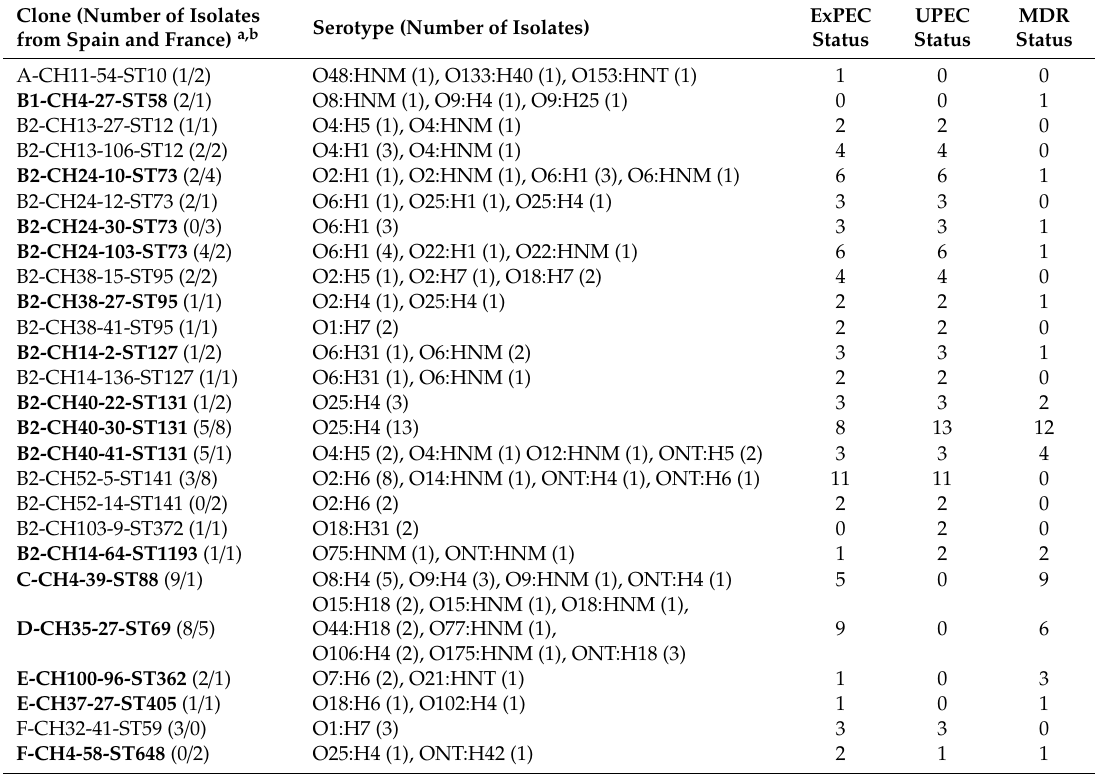
Serotype (Number of Isolates)